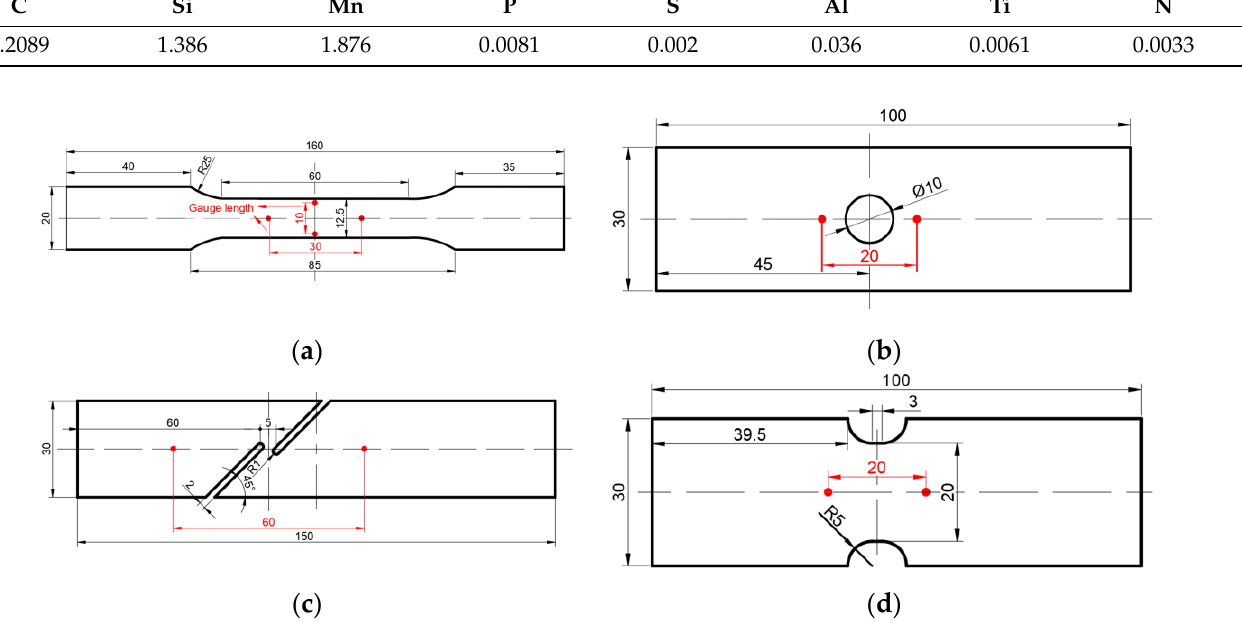
Table 2. The applied tensile velocities for different specimens